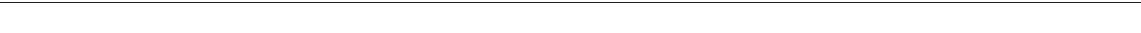
Fig. 7 IL-33 is released in complex with histones. TE-7 pools with stable, Dox-inducible overexpression of wild-type (WT) or truncated (Trunc) IL-33 were subjected to cryoshock, and the presence of high molecular weight IL-33 species in the supernatants was subsequently determined by size-exclusion chromatography. a IL-33 protein levels in different fractions as determined by ELISA, with normalization to the fraction with the highest amount of IL-33. Dashed arrow indicates where WT IL-33 is predicted to elute based off of a previously generated protein standard curve. b Proportion of IL-33 present in indicated fractions from a . c High molecular weight (corresponding to 35 – 39 mL retention volume, H) and low molecular weight (corresponding to 55 – 59 mL retention volumes, L) were pooled, concentrated by acetone precipitation, and subjected to western blot analysis for IL-33 and histone H2B. example of three independent experiments. b , d depict mean and standard error of the mean of cumulative data from three independent experiments. e TE-7 pools with stable, Dox-inducible overexpression of WT IL-33 were subjected to cryoshock, and then co-immunoprecipitation with anti-histone H2B antibody ( α H2B), isotype control (IgG1), or Protein A/G beads alone (Beads) was performed. Protein expression in eluates of IL-33 and histone H2B was assessed by western blot analysis. Black dashed arrows indicate bands corresponding to IL-33 and H2B. f Supernatants from pools of TE-7 cells with stable, Dox-inducible overexpression of WT IL-33 subjected to cryoshock were concentrated with a centrifugal fi lter with a 100 kDa molecular weight exclusion. HMC-1 mast cells that had been pre-treated with anti-ST2 or control IgG for 1 h were then treated with dilutions of either the input or concentrate as indicated. Depicted is mean and standard error of the mean of a representative example of two independent experiments. **, p < 0.01 by Student ’ s